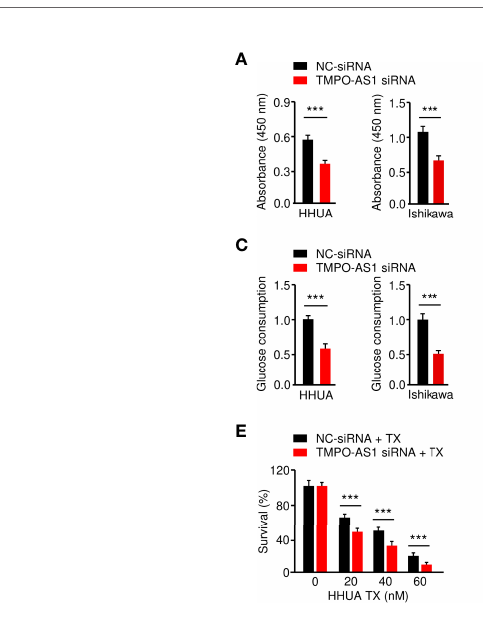
FIGURE 9 | Knockdown of TMPO-AS1 Inhibits Glycolysis and Reverses Chemoresistance of EC Cells. (A – D) Proliferation (A) , invasion (B) , glucose consumption (C) , and lactate production (D) assays in EC cells after the knockdown of TMPO-AS1. (E, F) HHUA (E) or Ishikawa cells (F) were transfected with TMPO-AS1 siRNA (or control siRNA) and treated with different concentrations of paclitaxel. Cell viability was examined using a CCK-8 assay. *** P <